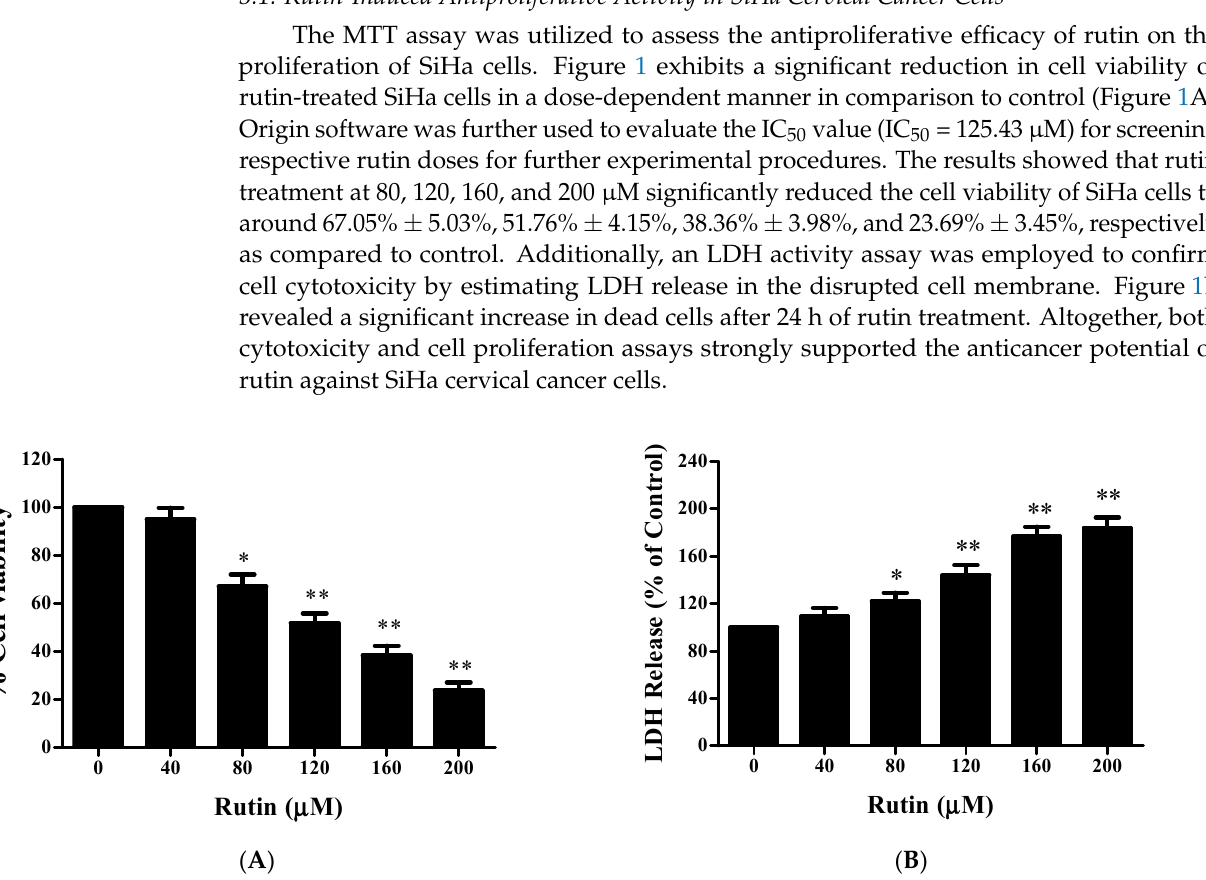
Figure 1. Effect of rutin on the viability of cervical cancer SiHa cells. ( A ) Bar diagram presenting cell viability of SiHa cells exposed to various concentrations of rutin (0–200 µM) for 24 h as assessed by MTT assay. ( B ) Cytotoxic effects of rutin analyzed by lactate dehydrogenase (LDH) enzymatic activity in human cervical cancer SiHa cells. The results are represented as mean ± SEM of three independent experiments (* p < 0.01, ** p < 0.001 compared with control group).